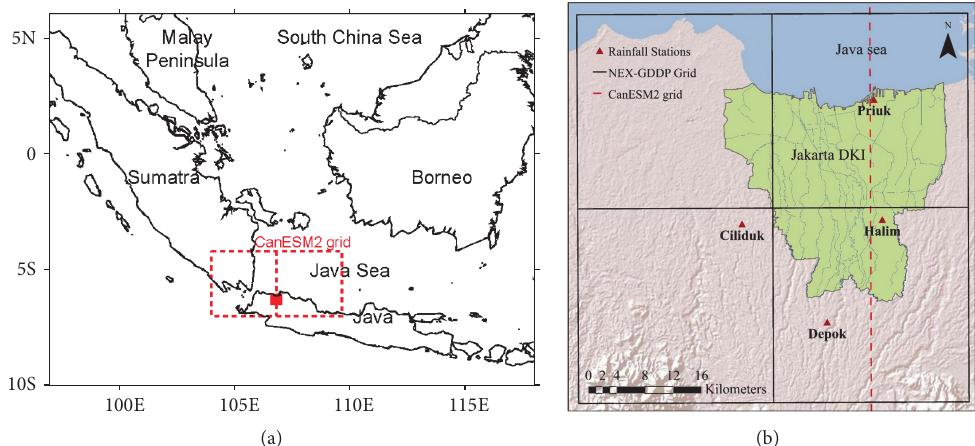
Figure 1: Map of the western Maritime Continent (a) showing the study area of Jakarta (filled red square) and CanESM2 grids and map of Jakarta (b) showing the rain gauges used and the NEX-GDDP grids. The red lines represent the CanESM2 grid. The green shaded area denotes the Jakarta DKI